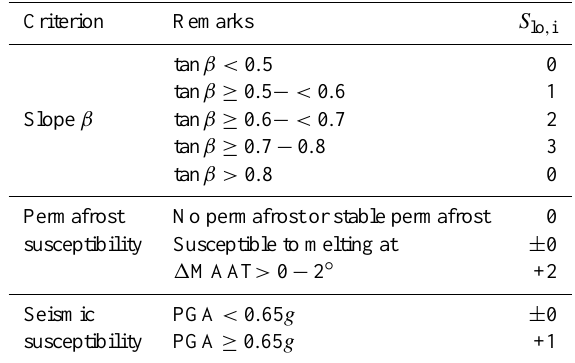
Table 6. Scoring scheme for periglacial debris flow susceptibility S pf